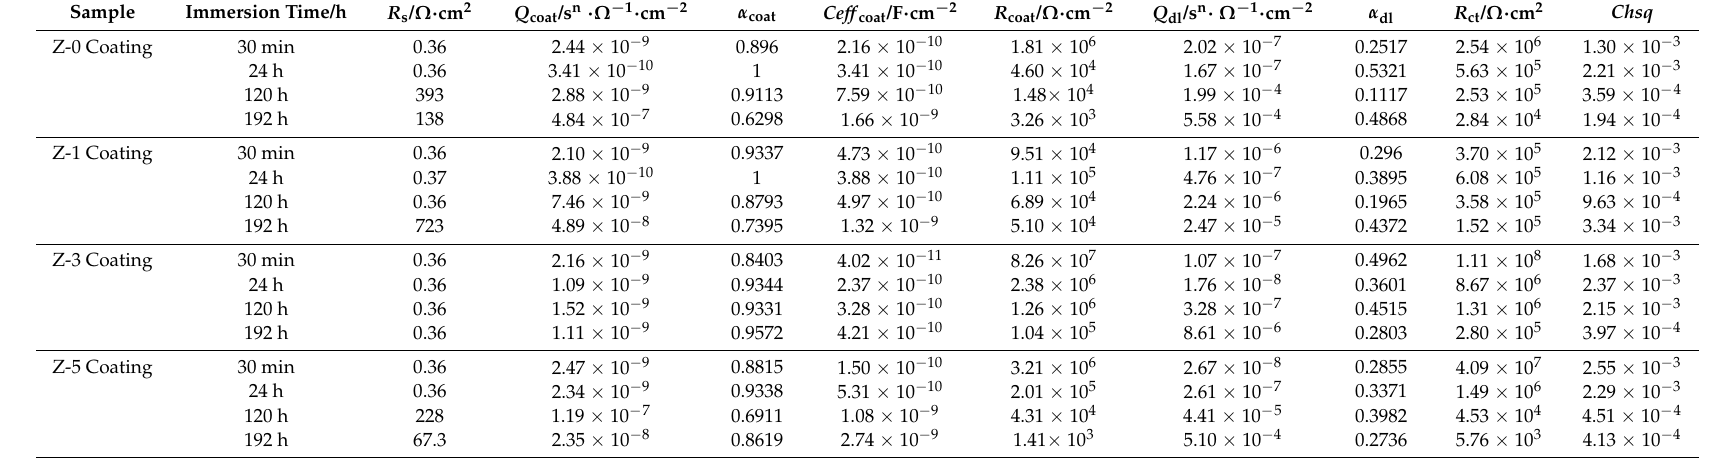
Table 4. Fitting results of EIS for the Z-0, Z-1, Z-3, and Z-5 coatings after different acid immersion